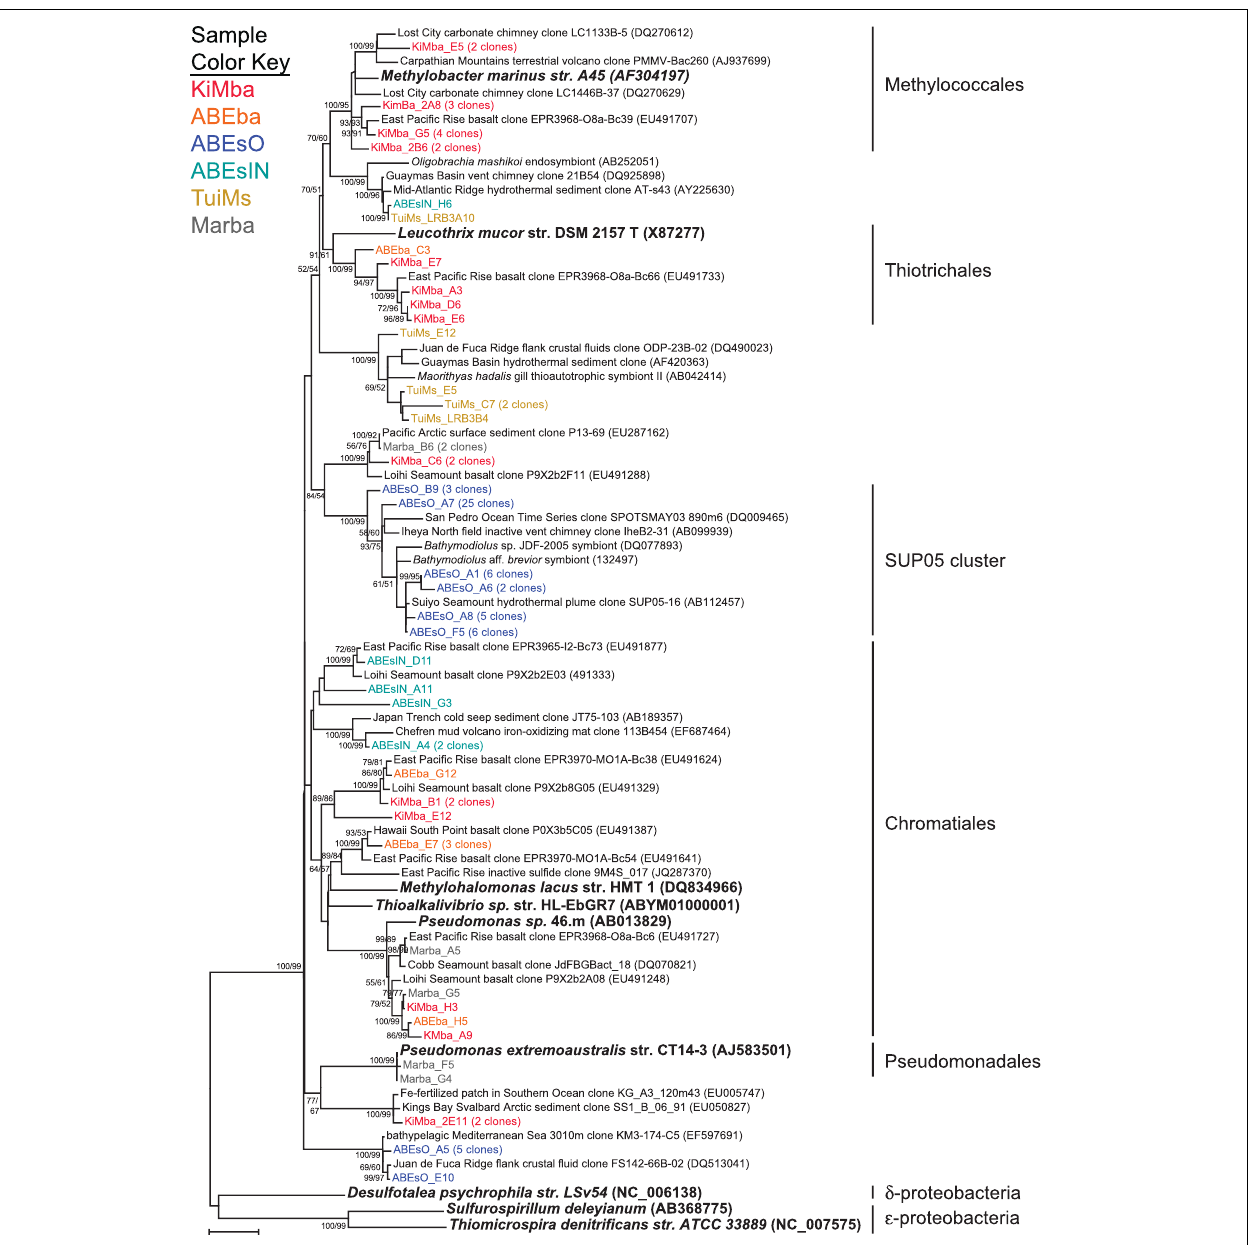
FIGURE 5 | Phylogenetic tree of representative clones from this study that fall within the γ -proteobacteria. Clones with more than one representative, or for which multiple members fell into a single clade, were chosen. Numbers in parentheses after some clones indicate total number of clones represented by the single clone depicted.The tree was generated in MEGA 5 using the maximum likelihood method with the Jukes–Cantor model and a Gamma distribution and 1000 bootstrap replicates.The same alignment